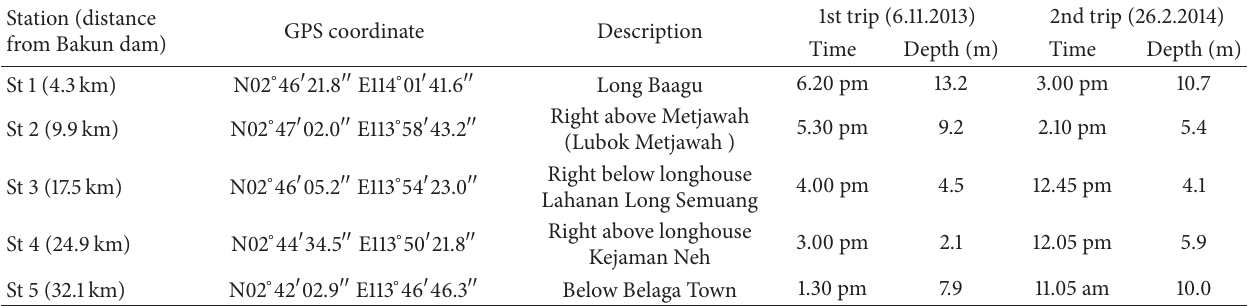
Table 1: The details of the sampling location and sampling regime in the present study. Station (distance from Bakun dam)